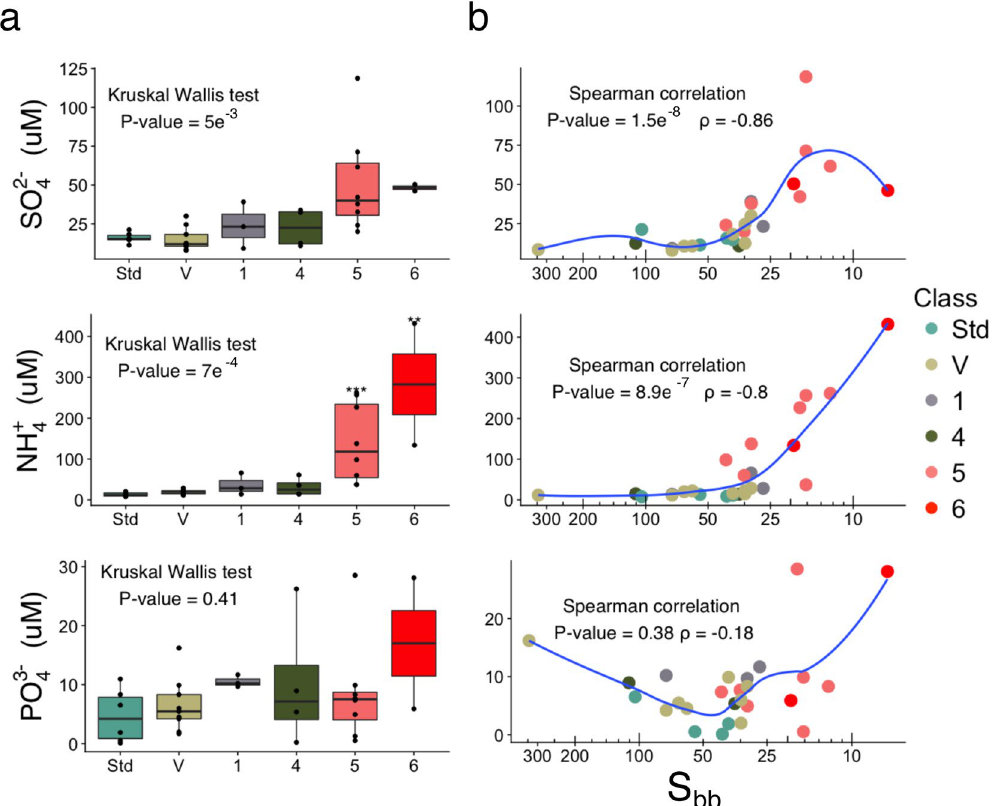
Figure 6. Variation in NH 4 + , SO 42 − , and PO 43 − concentration in maple sap. ( a ) Boxplots of concentration by sample quality as defined in Table 1 showing that NH 4 + and SO 42 − are significantly different between Std and class 5 syrups. Syrups with defects were compared to the Std group with a Dunn’s test after a Kruskal Wallis test (P-value < 0.05). * Denotes a significant difference (P-value < 0.05). Boxplots show the median, 1 st and 3 rd quantiles. ( b ) Sap variation in NH 4 + and SO 42 − are correlated to dormancy release (S bb ) (Spearman P-value < 0.05) while PO 43 − is